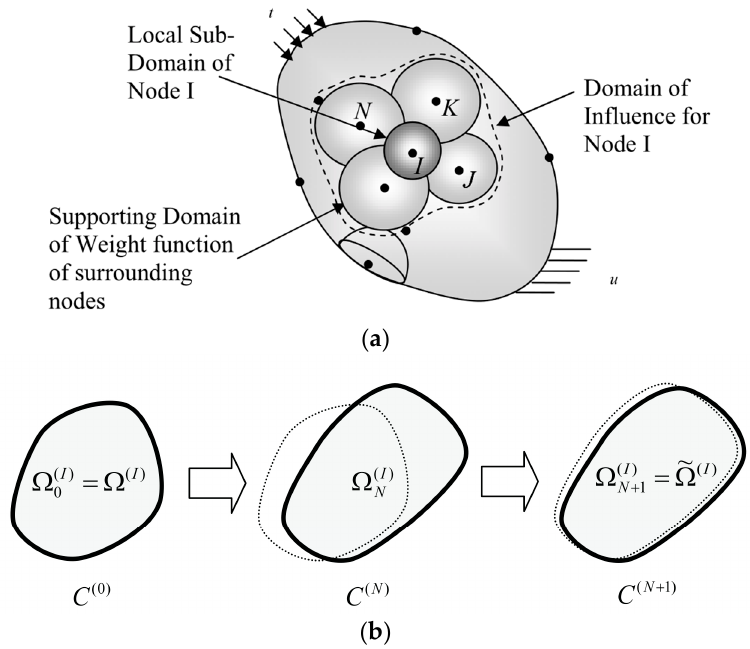
Figure 2. Description of MLPGEM: ( a ) trial and test domain; ( b ) three configurations during a finite deformation.